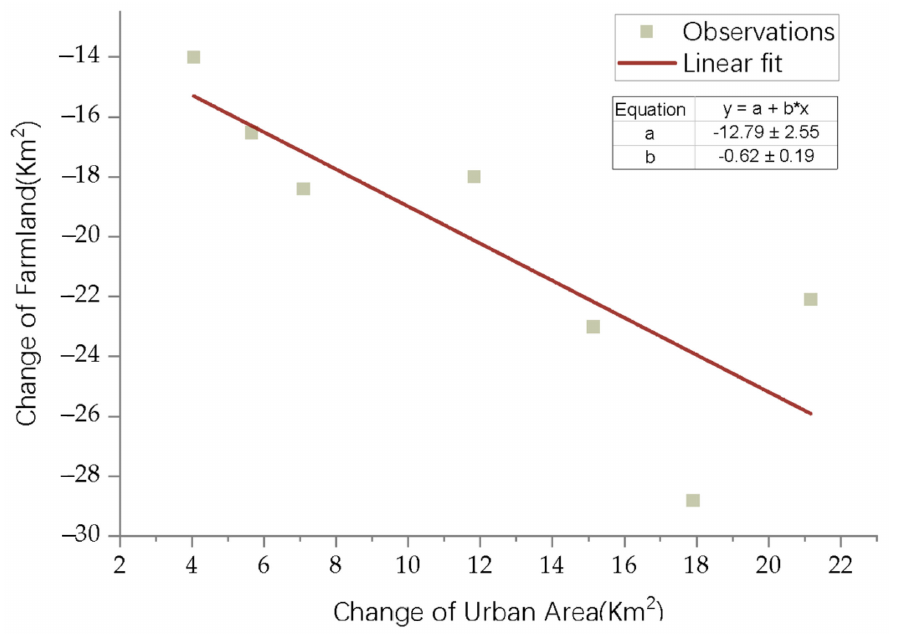
Figure 11. Correlation analysis between the change of urban area and farmland. The observations are obtained from the seven interest districts of the